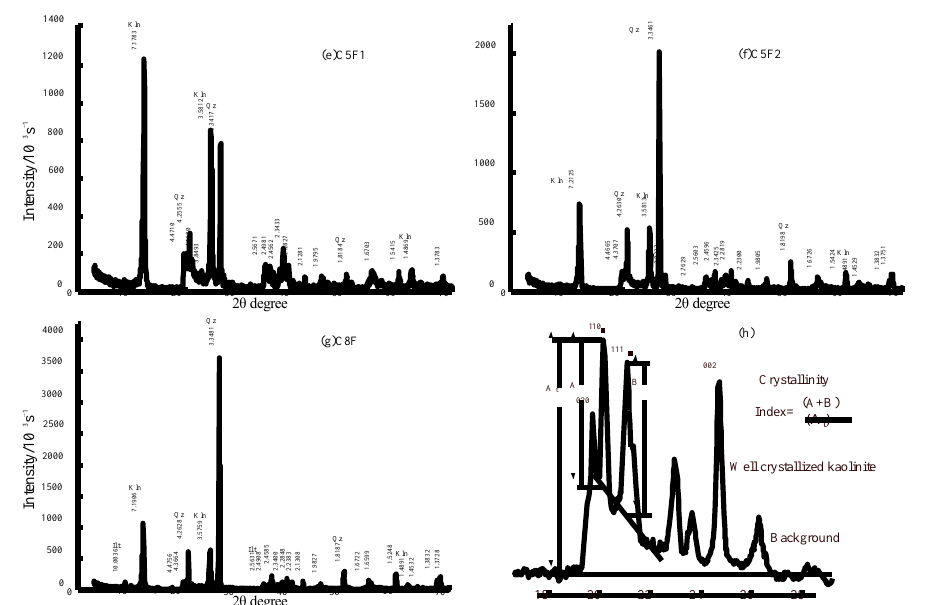
Figure 5. The XRD patterns of kaolinite rocks in Xiaoyu mine. Kln, kaolinite; Qz, quartz; Dsp, dias- pore; Ilt, illite; Ant, anatase; Bhm, boehmite; Py pyrite. A t is the height from the peak to the baseline, while A and B are the height of sum peaks, respectively. ( a – g ) represent samples S4F, C2F, C3R, C5G, C5F1, C5F2 and C8F, respectively; ( h ) revised from Hinckley [33].